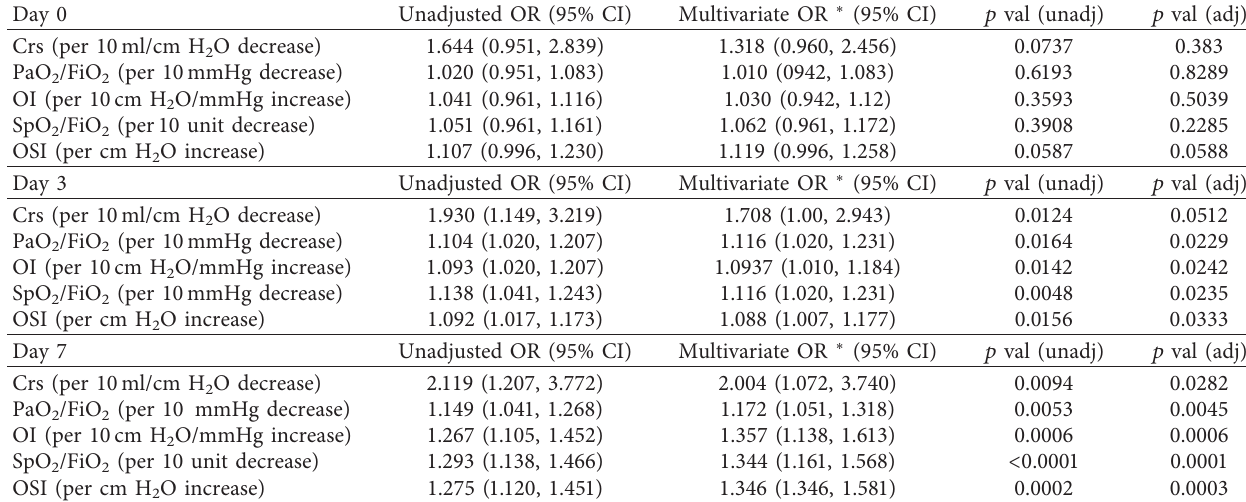
SpO 2 /FiO 2 ratio Oxygen saturation index Data are presented as median (interquartile range). Table 3: Unadjusted and multivariate adjusted odds ratio of death for Crs, PaO Day